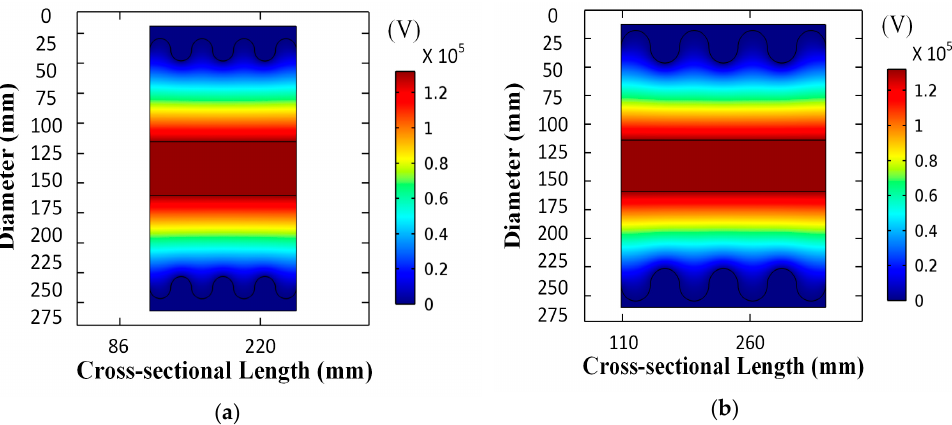
Figure 5. Electric potential comparison of corrugated RP GIL: ( a ) Pitch = 38 mm; ( b ) Pitch = 58 mm.